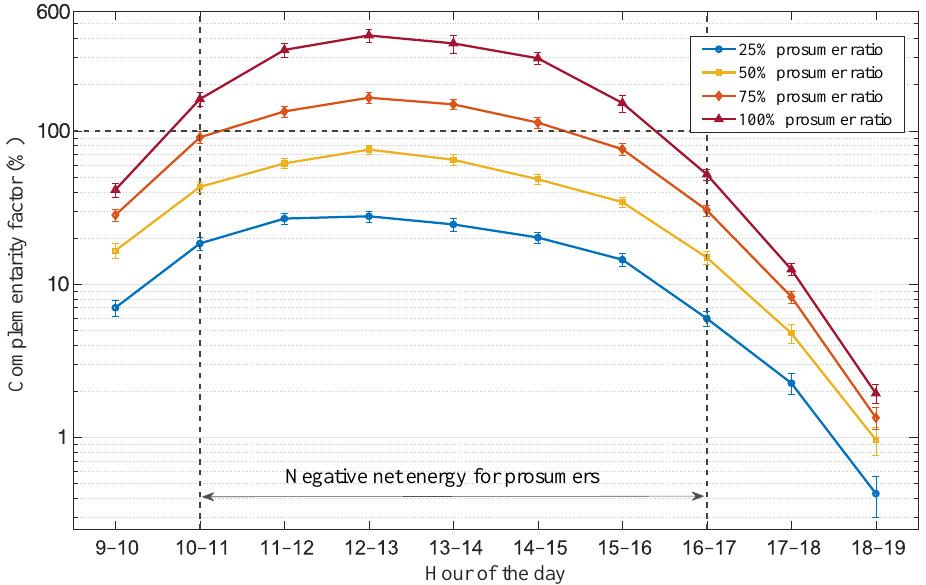
Figure 10. Impact of varying prosumer ratios on complementarity factor of the community during PV generation hours for 25%, 50%, 75%, and 100% prosumers’